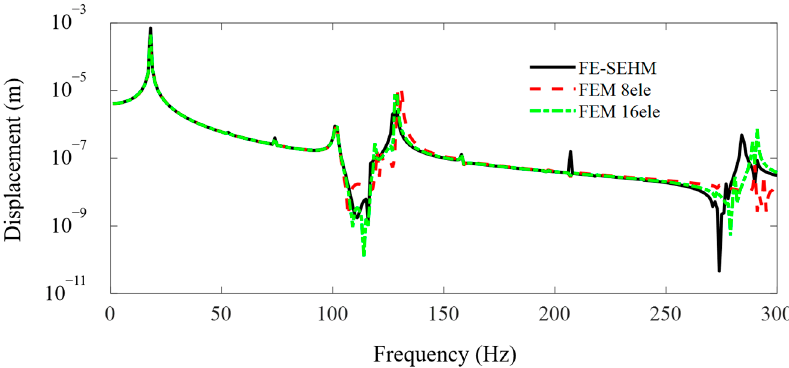
Figure 4. The FRF curves of the metamaterial plate at point A of the cover plate along the x axis obtained by the FEM and the FE-SEHM.